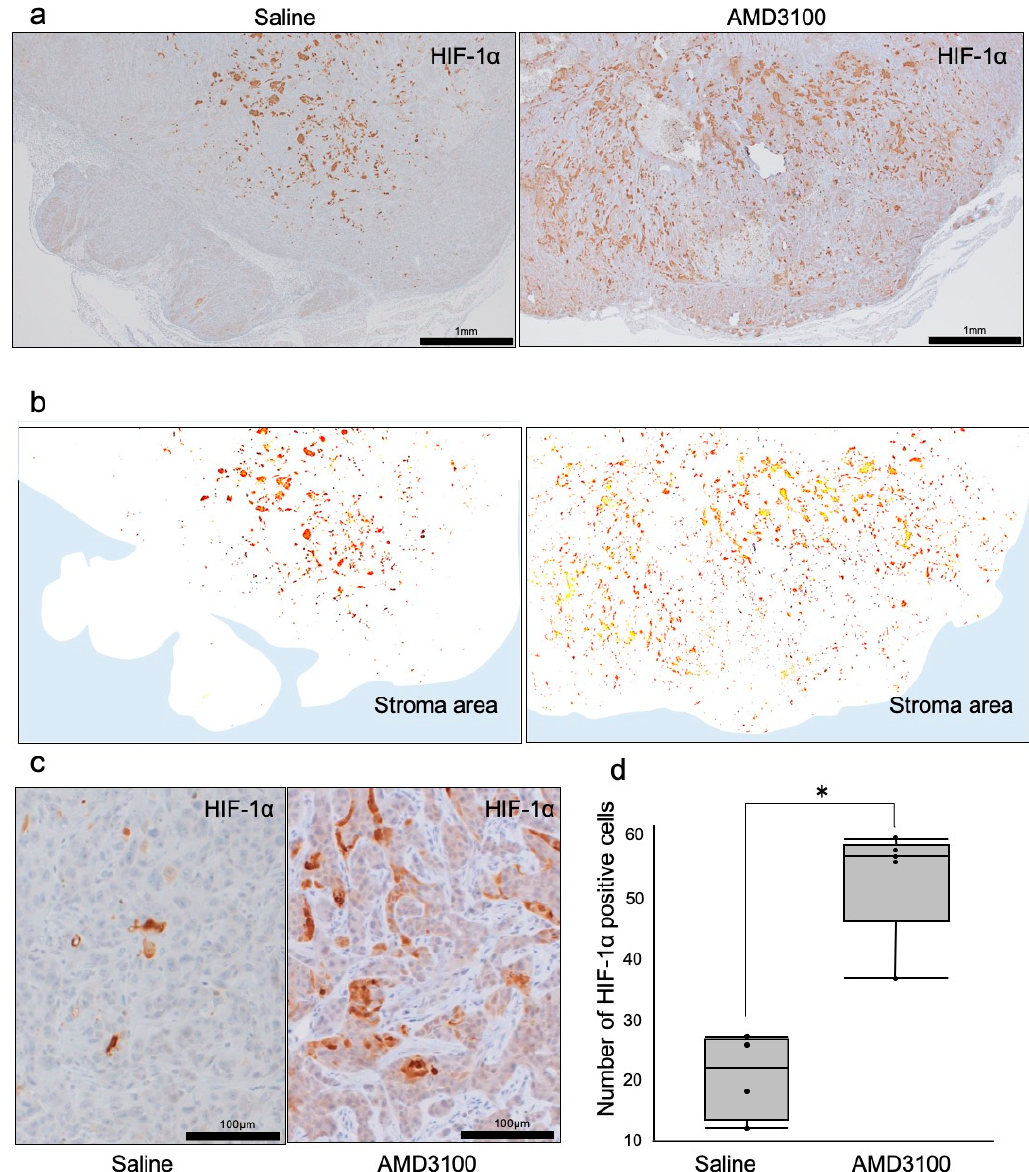
Figure 5. Distribution of hypoxia-inducible factor-1 α (HIF-1 α ) in tumors treated with or without CXCR4 antagonist AMD3100. ( a ) IHC for HIF-1 α in the tumor area under low-power magnification. ( b ) Illustration of HIF-1 α distribution in tumors. White area, tumor. Blue area, stroma. ( c ) IHC of HIF-1 α under high-power magnification. ( d ) The number of HIF-1 α -positive tumor cells. * p = 0.02, N = 5 mice.